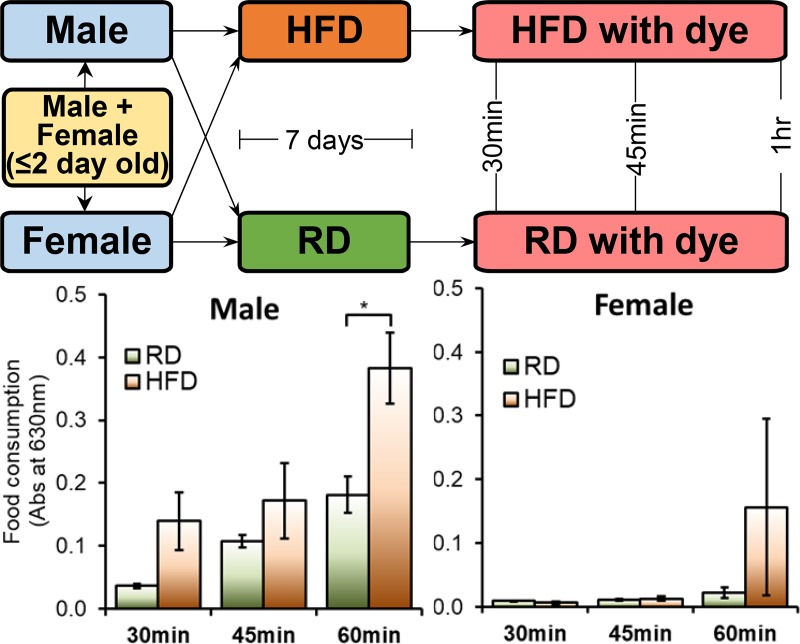
High fat diet induced hyperphagia in both males and females.(A) Schematic of the quantification of food consumption. The amount of food consumed by (B) males and (C) females that were chronically fed on a RD and a HFD. Food intake was measured at indicated time points.